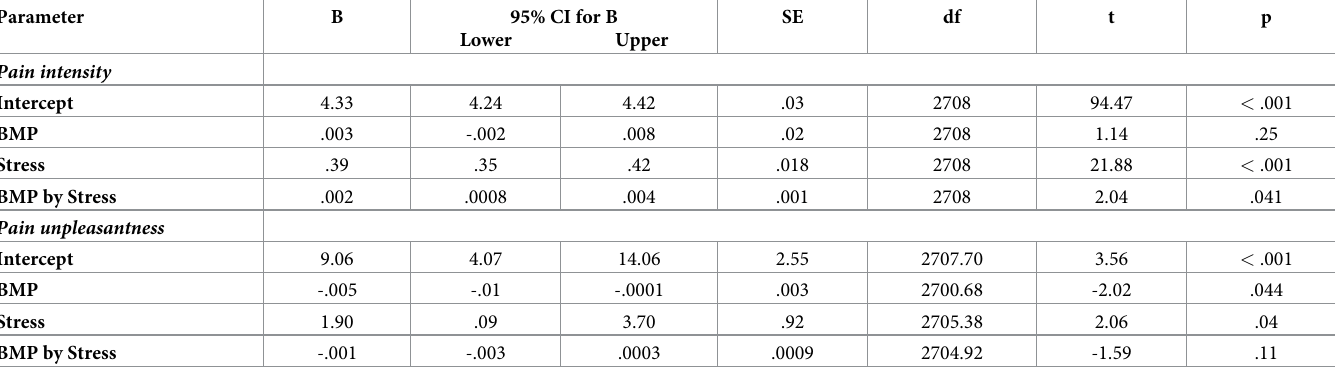
Table 4. Moderator analysis for pain intensity and pain unpleasantness